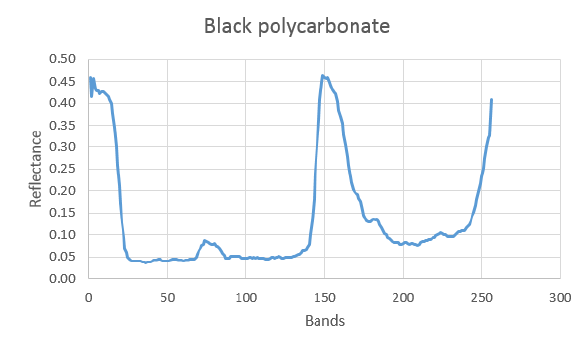
Figure 10. Spectral signature of the reference